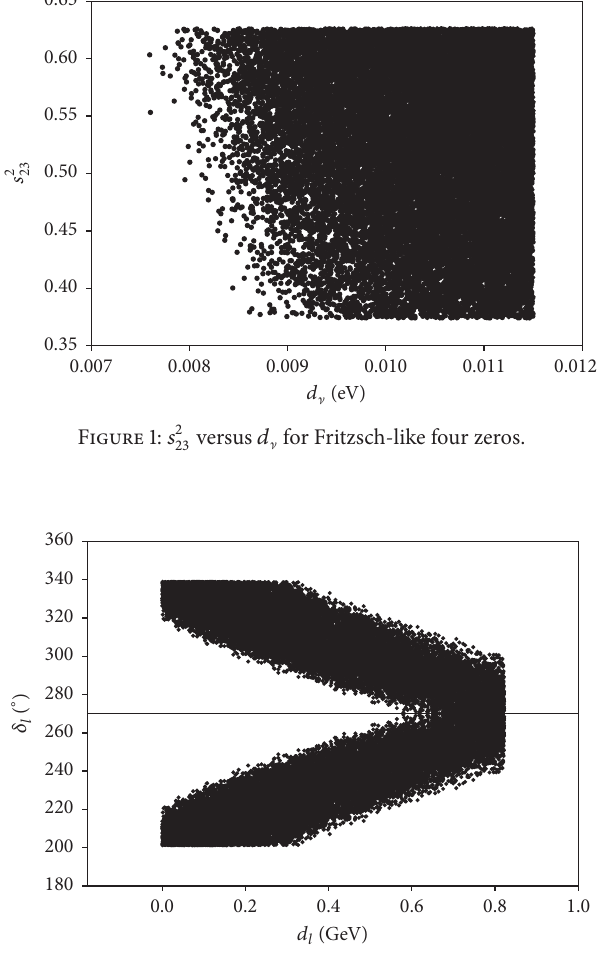
Figure 2: 𝛿 𝑙 versus 𝑑 𝑙 for Fritzsch-like four zeros.